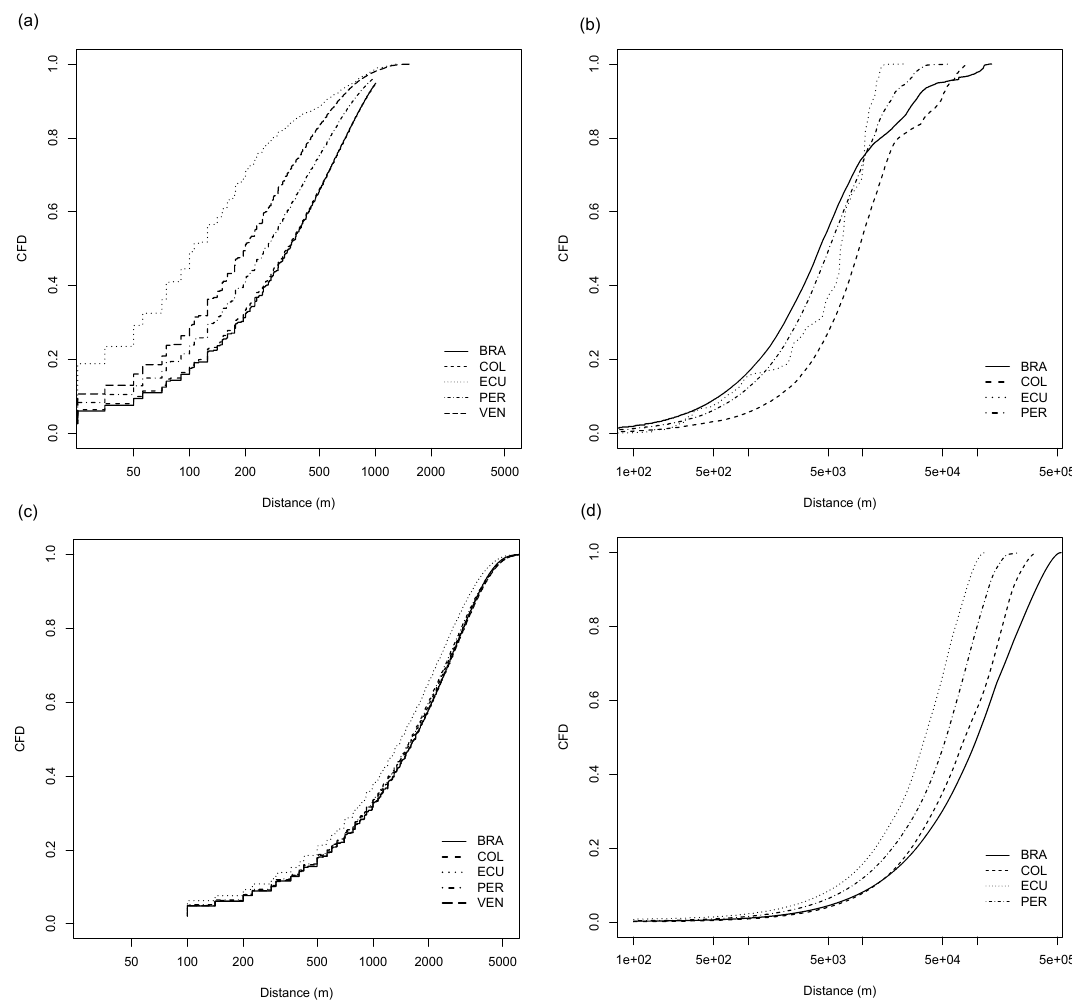
Figure 4. Cumulative frequency of the observed closest distance of fires to rivers (a) and roads (b) for each country and of the null model for distances to rivers (c) and roads (d) for each